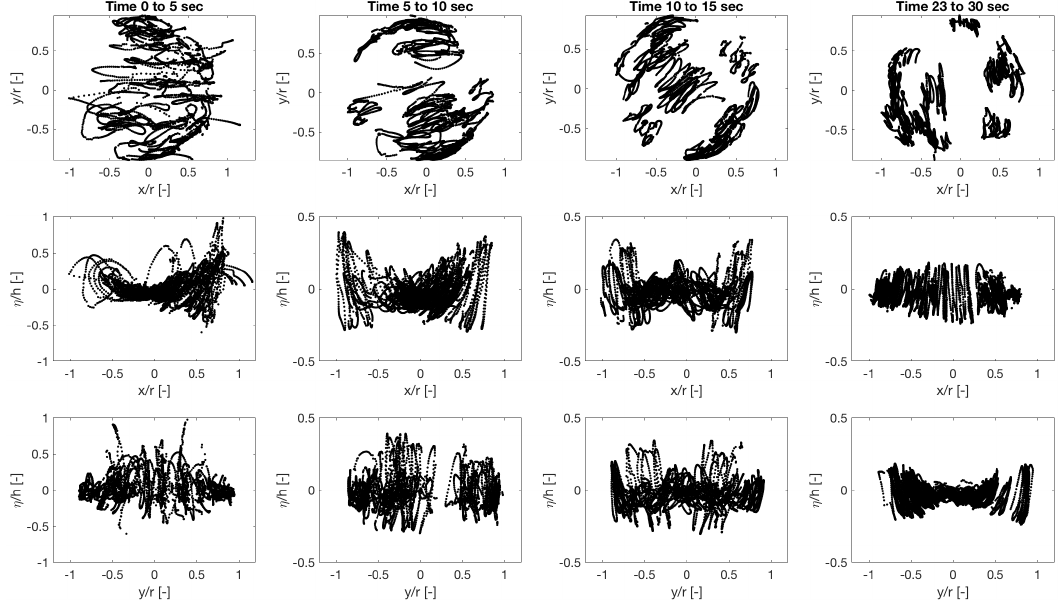
Figure 8. Results of the transient experiment—3D location of the measured marker balls; four different time periods (columns) and three different view directions